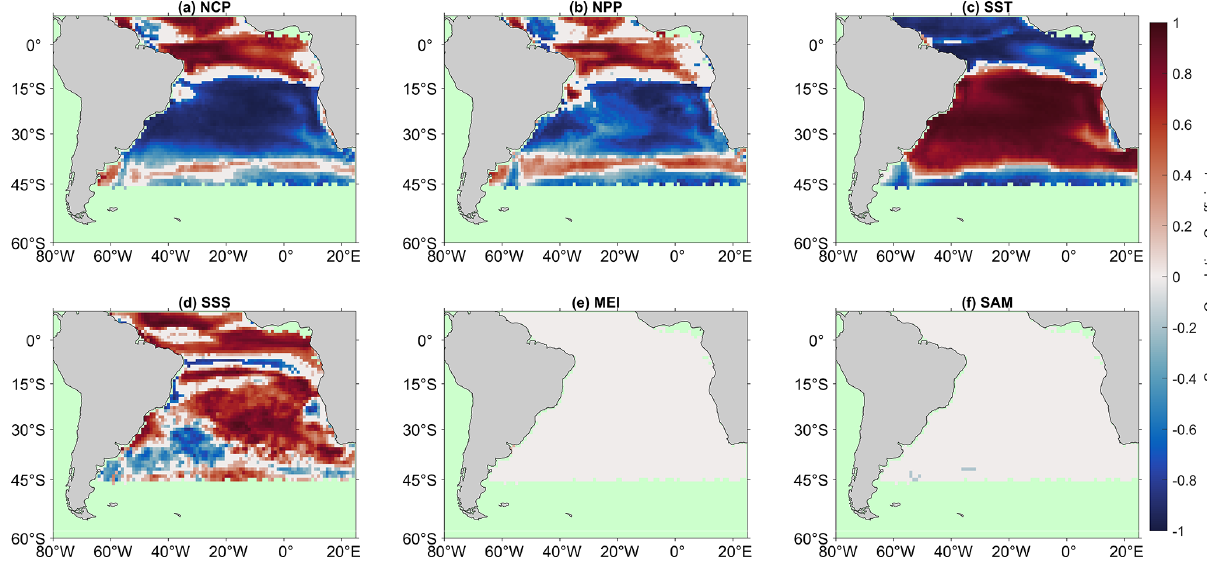
Figure 2. Significant Spearman correlations between the air–sea CO 2 flux seasonal component of the X-11 analysis and (a) net community production (NCP), (b) net primary production (NPP), (c) sea surface temperature (SST), (d) sea surface salinity (SSS), (e) multivariate ENSO index (MEI), and (f) Southern Annular Mode (SAM) seasonal components. White regions indicate no significant correlations, and green regions indicate no analysis was performed due to missing satellite data.